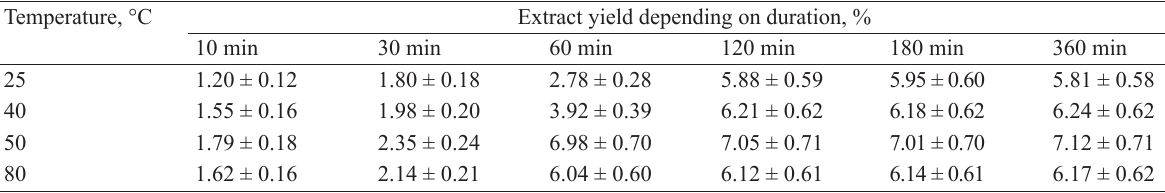
Table 2 Temperature selection for extracting biologically active substances from ginseng callus cultures Temperature, °С Extract yield depending on duration,